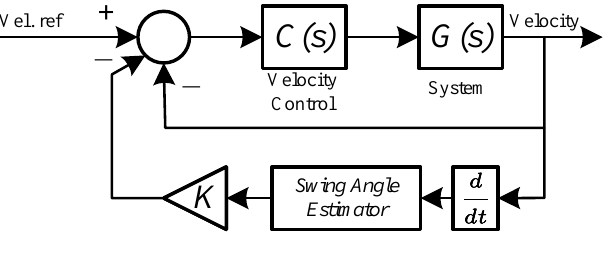
Figure 3. Proposed closed-loop method with a swing angle estimator. Acceleration of the trolley is the input to the estimator. It outputs the estimated angle, which is then multiplied by a tuning parameter K